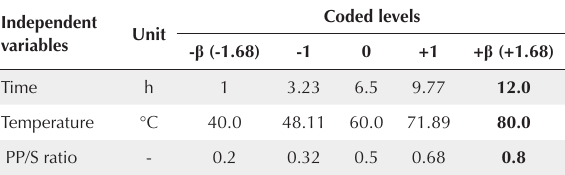
Table 1. Range of variables and their levels used in RSM design Independent Unit variables